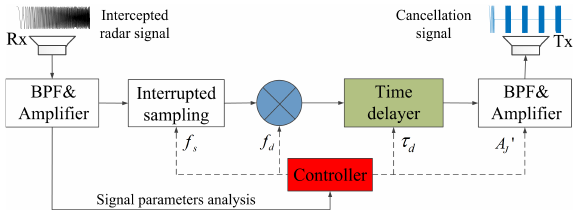
Figure 2. Block diagram of the canceller.